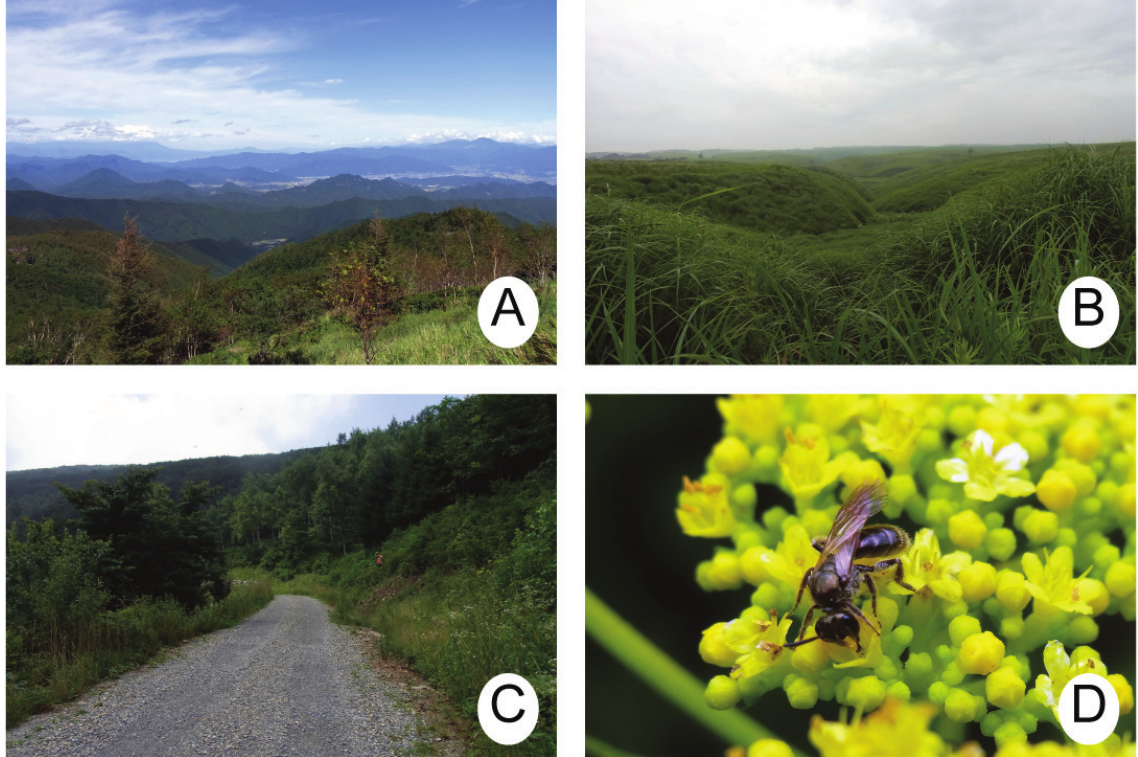
Fig. 23. habitats in Japan and South Korea. A . Takeshikakami-honiri, ueda-shi, Nagano Pref., Japan. B . Matoishi wilderness, aso-shi, Kumamoto Pref., Japan. C . Mt. Gariwangsan, Gangwon-do, South Korea. D . Lasioglossum ( Dialictus ) miyabei Murao et al ., 2006, ♀ on flowers of Patrinia scabiosifolia Fisch. ex Trevir. in